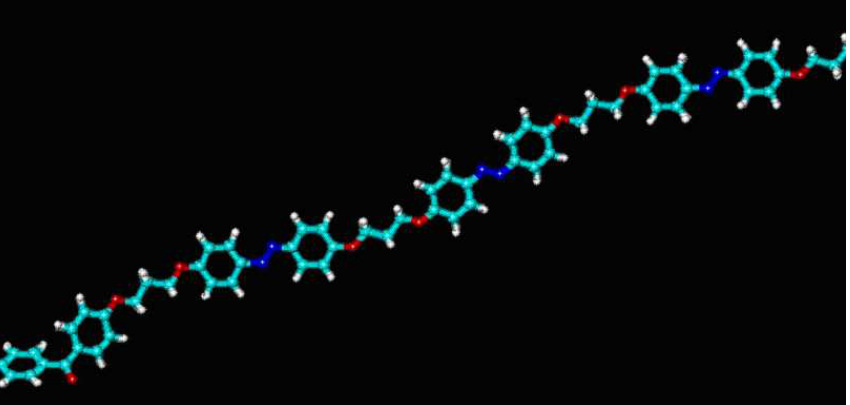
Fig. 1 Chain geometry corresponding to Sample 1.